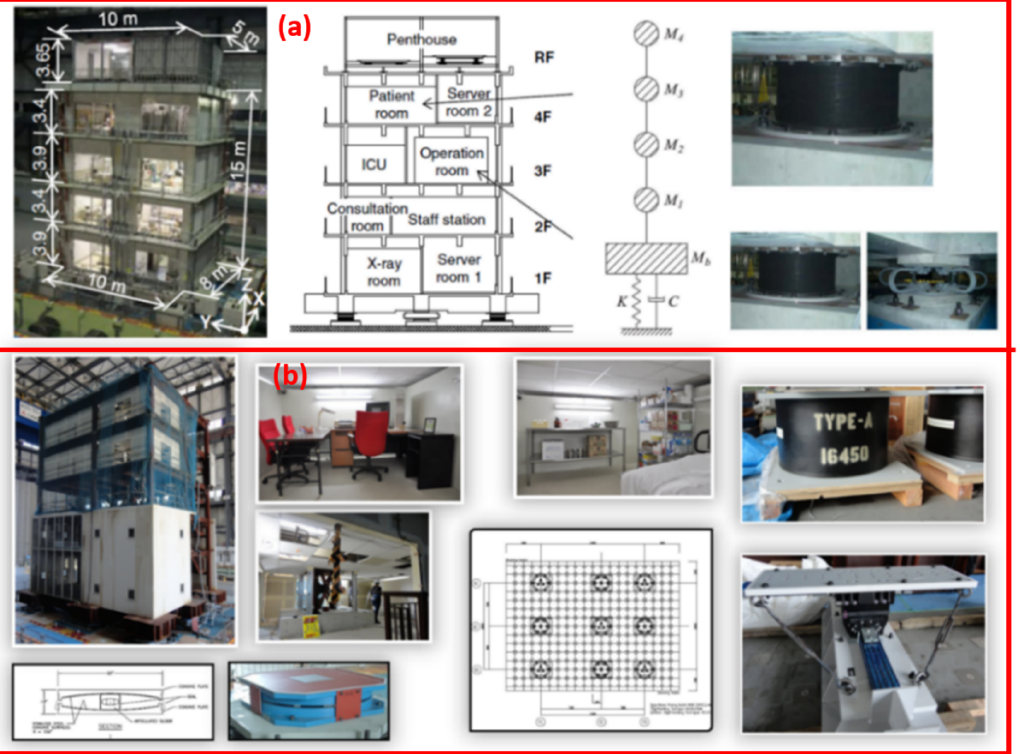
Figure 27. ( a ) Full-scale hospital building equipped with HDRB, LDRB, and U-Dampers at different stages of the E-Defense test program (Courtesy of E-Defense) ( b ) Full-scale seismically isolated steel structure equipped with CSFS, LRB, and cross linear devices at different stages of the E-Defense test program [91–93,101,102] .